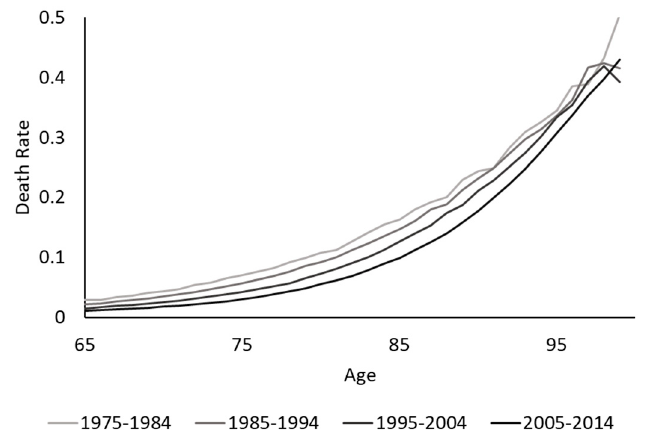
Figure 1. Australian male central death rates for 1975 to 2014.